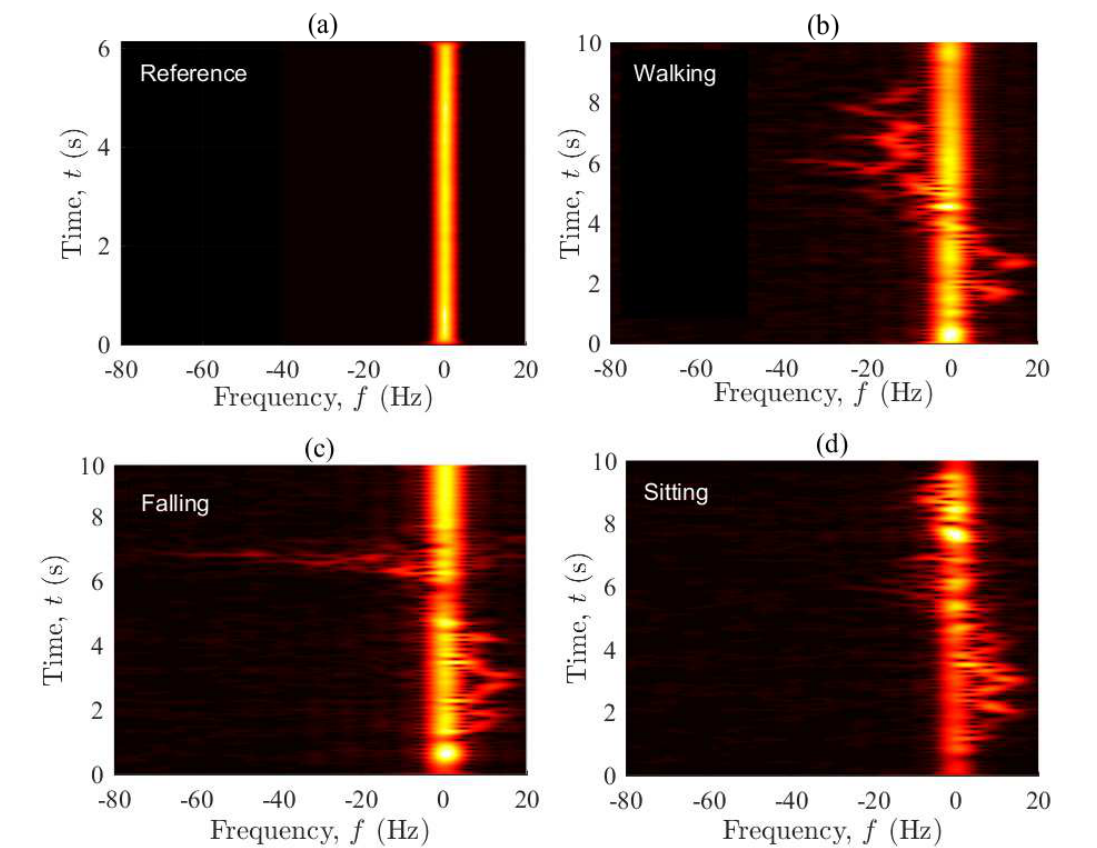
Figure 4. The spectrogram S (cid:63) xx ( f , t ) of the complex channel gain µ (cid:63) ( t ) for the four scenarios in S1: ( a ) reference, ( b ) walking, ( c ) falling, and ( d )